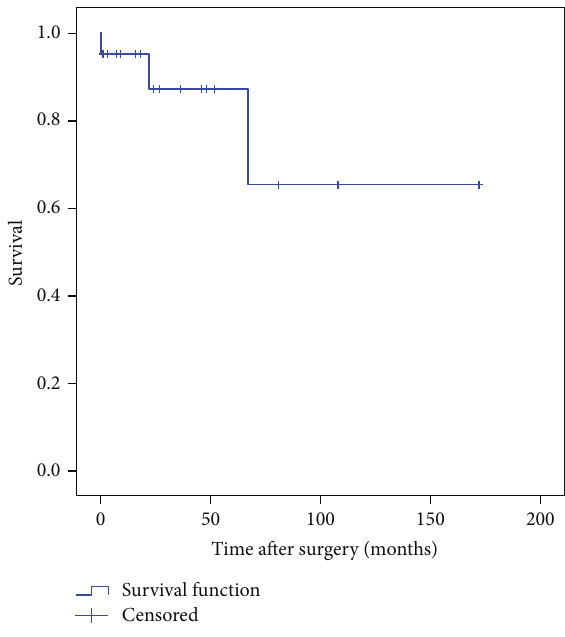
Figure 2: Implant survival.